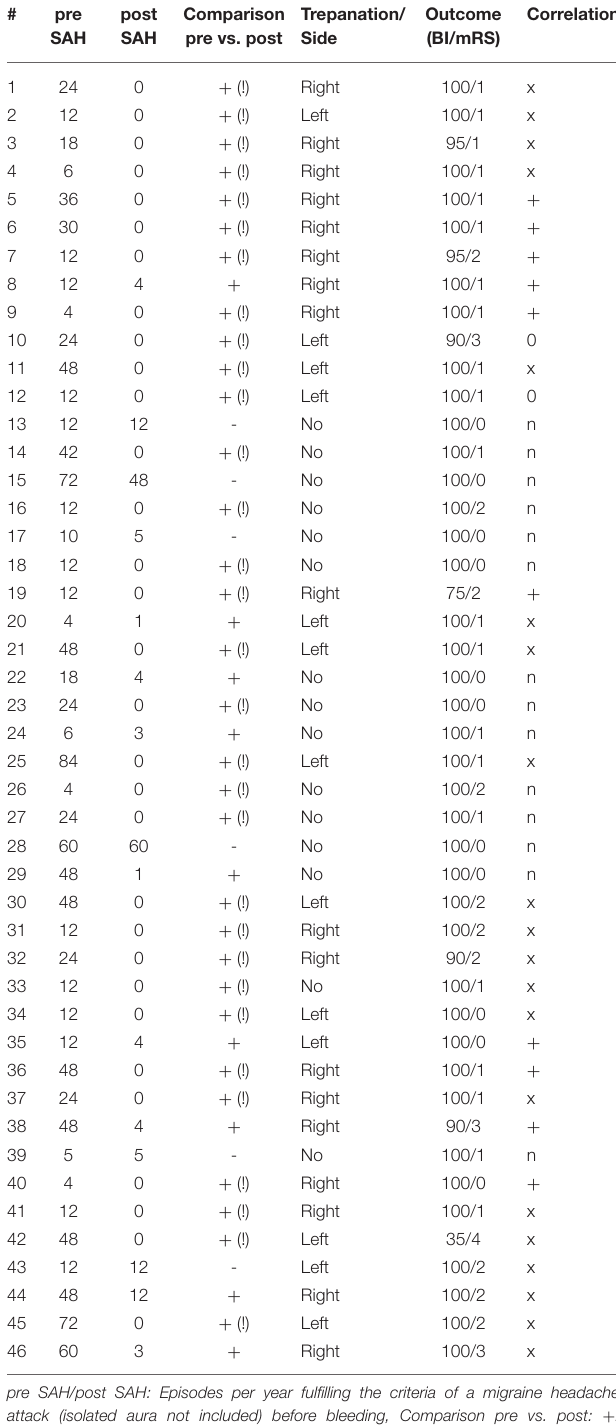
TABLE 3 | Migraine situation prior to subarachnoid hemorrhage (SAH) and long-term course following SAH. # pre post Comparison Trepanation/ Outcome SAH SAH pre vs. post Side (BI/mRS)